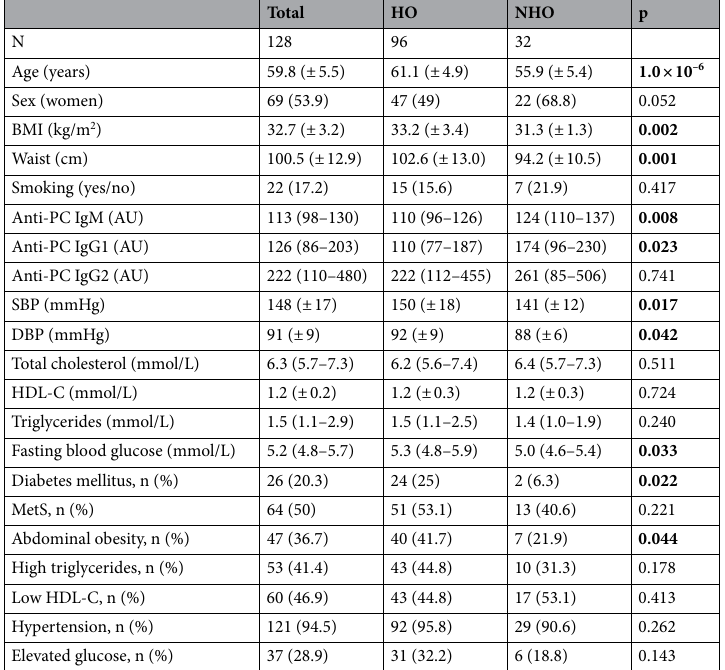
Table 1. Characteristics of the study population. Bold indicates significance (p≤0.05) Values are means (± standard deviation), medians (25–75 interquartile range), or numbers (%). Components of the Metabolic syndrome (Abdominal obesity (waist circumference ≥ 88 cm and ≥ 102 cm for women and men, respectively), elevated triglycerides (≥ 1.7 mmol/L), reduced high density lipoprotein cholesterol (< 1.03 mmol/L in males and < 1.29 mmol/L in females), hypertension (systolic blood pressure ≥ 130 mmHg and/or diastolic blood pressure ≥ 85 mmHg, or drug treatment), or elevated fasting glucose (≥ 5.6 mmol/L or glucose-lowering treatment) were defined as stated by Alberti et al. 13 . HO hospitalized obese, NHO non-hospitalized obese, AU arbitrary units, Anti-PC antibodies against phosphorylcholine, Ig immunoglobulin, MetS metabolic syndrome, SBP systolic blood pressure, DBP diastolic blood pressure, HDL high density lipoprotein cholesterol. Bold indicates significance (p ≤ 0.05)